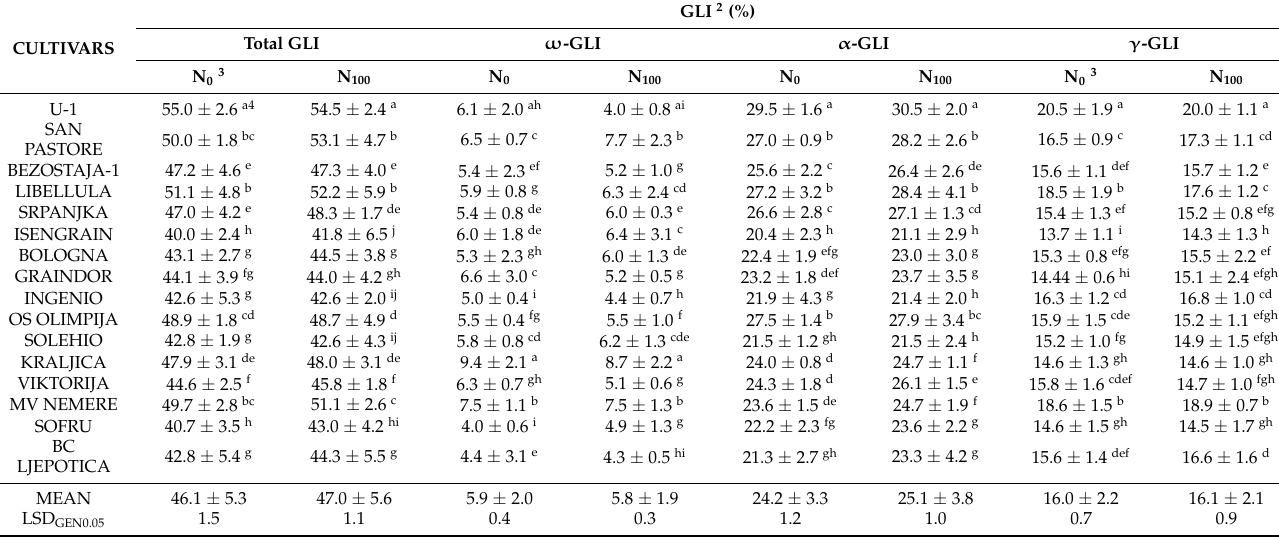
Table 3. Mean 1 values of GLI proportions in total grain protein of wheat under low and high N levels.